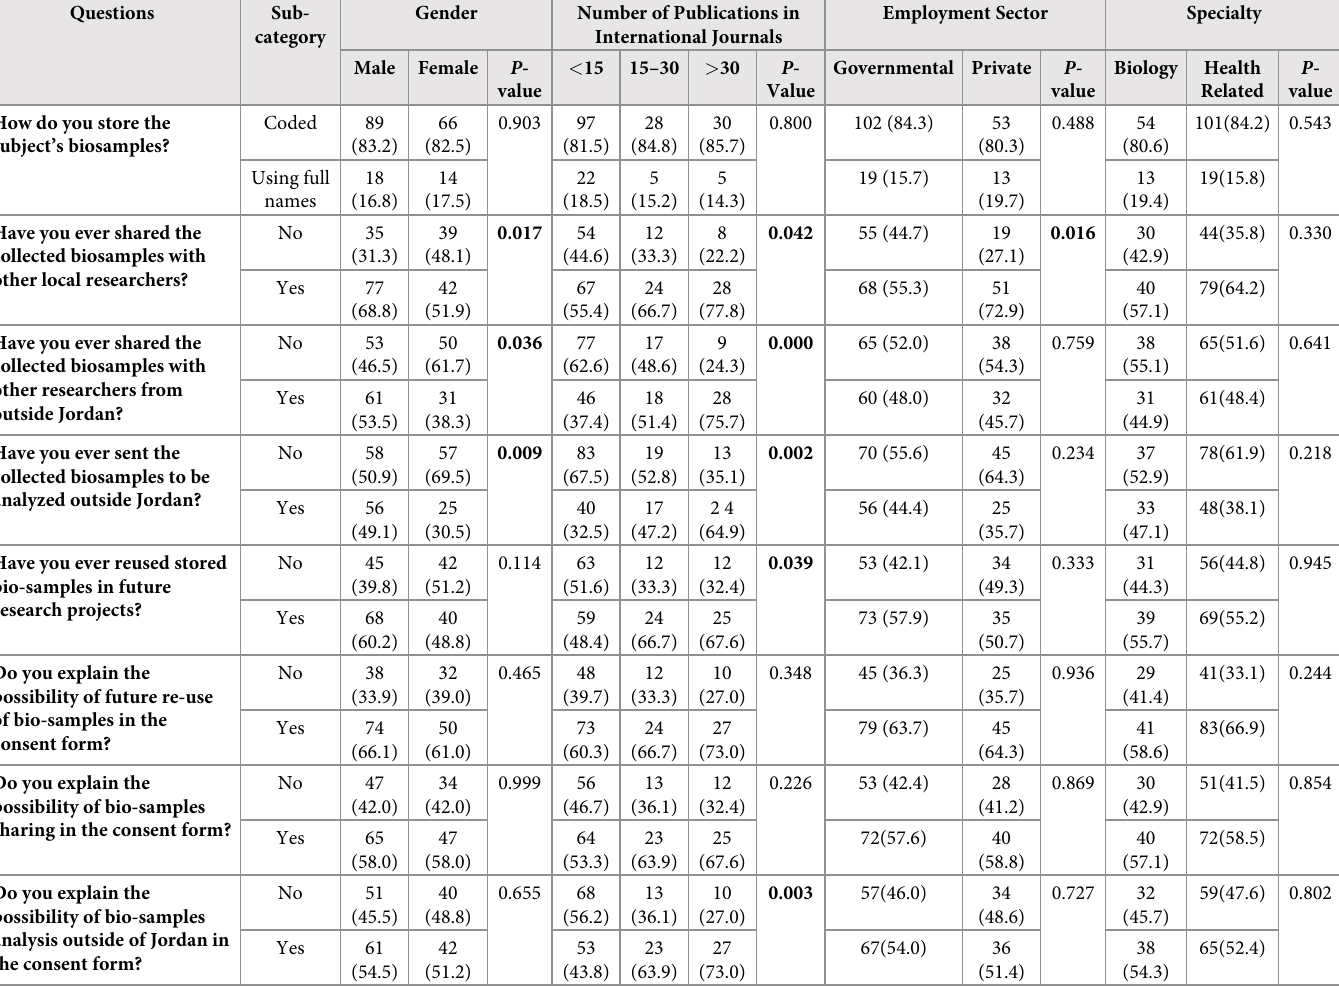
Table 3. Storage, analysis, and sharing of bio-samples among researchers in Jordan N (%), Crosstab